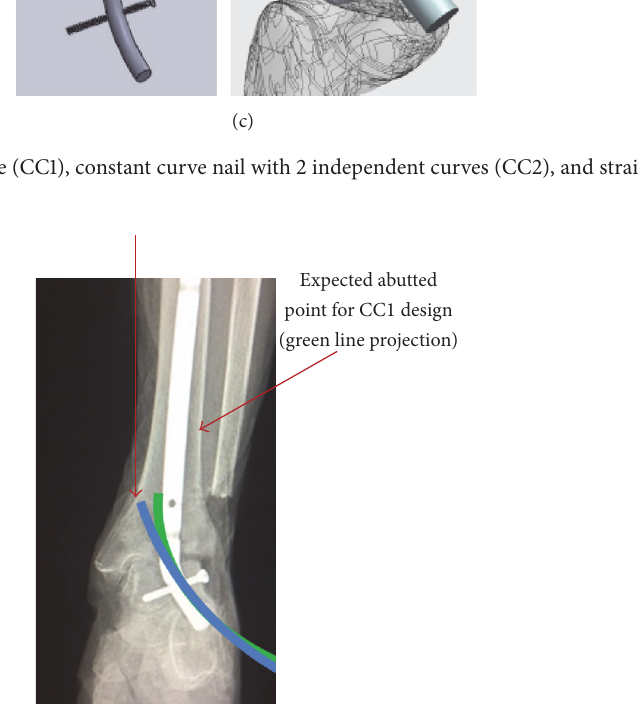
Figure 6: Green line represents current radius of curvature proposed with approximate abutment in lateral tibia; blue line represents larger radius of curvature theoretically allowing a longer implant in the tibial segment; however, it abuts the medial tibia instead of progressing